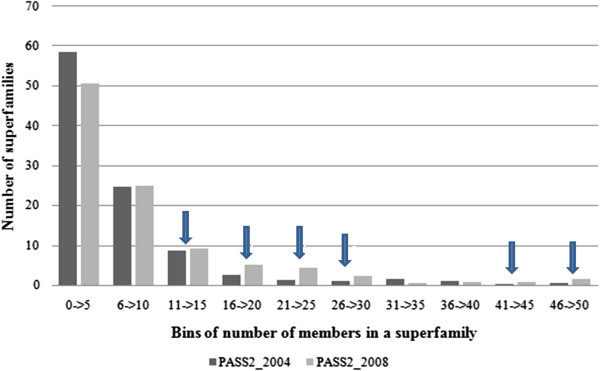
Distribution of number of superfamilies with respect to frequency of members in each superfamily (categorised as different bins).